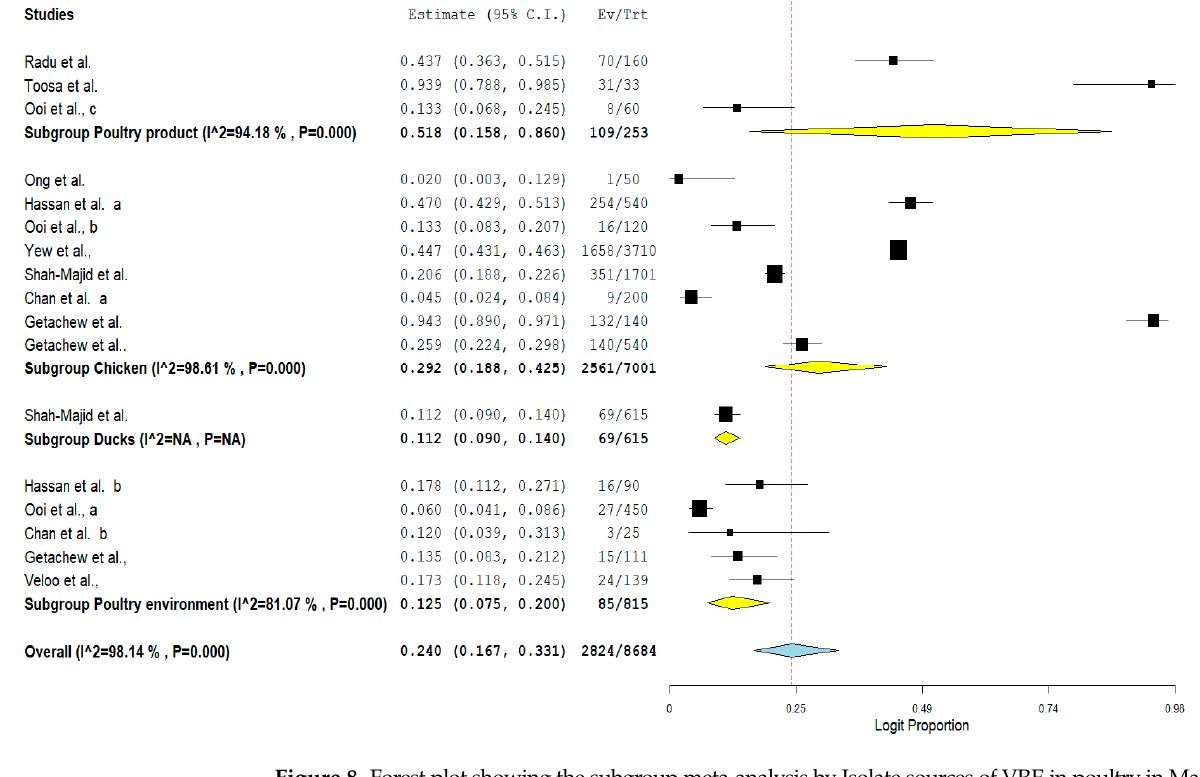
Figure 8. Forest plot showing the subgroup meta-analysis by Isolate sources of VRE in poultry in Malaysia. Lastly, the result of subgroup meta-analysis according to the detection method showed that 5 studies each utilized disc diffusion and agar dilution with a prevalence of 45.6% and 23.1%, respectively (Table 5). Only one study utilized polymerase chain reaction (PCR) as a method of detection with a prevalence of 43.7% and CI of 36.3–51.5%. (Table 5). The forest plot is shown in Figure 9. Table 5. Subgroup analysis for comparison of VRE in poultry in Malaysia across detection methods.